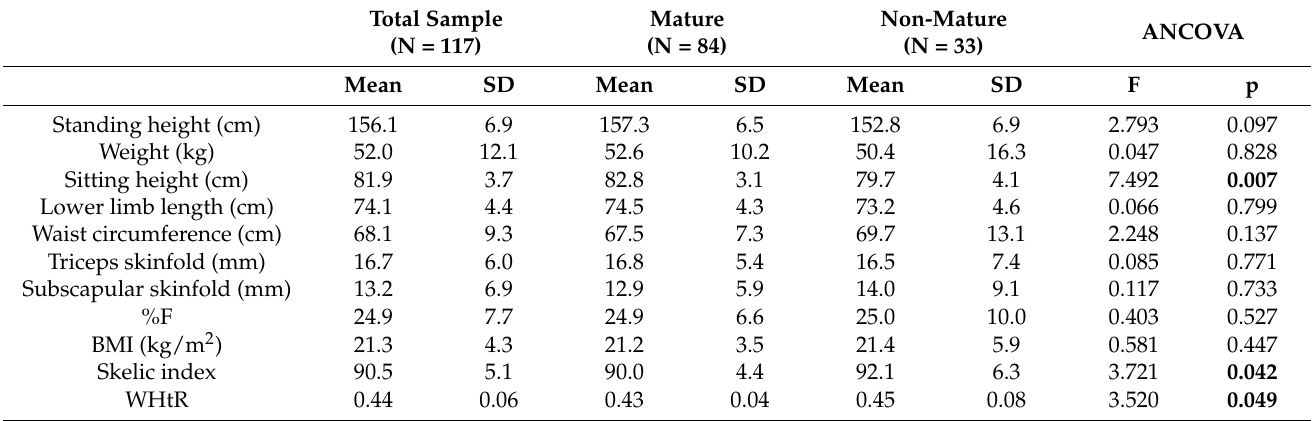
Table 1. Anthropometric characteristics of the sample by the onset of menarche.